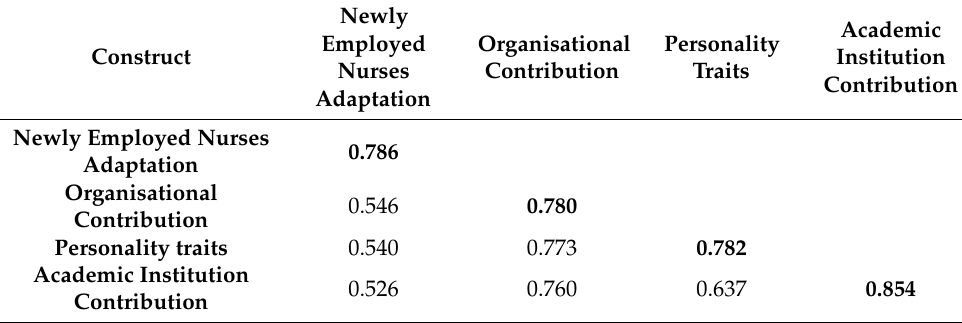
Figure 1. The four constructs are assessed together through a pooled-CFA procedure. Table 3. The discriminant validity index